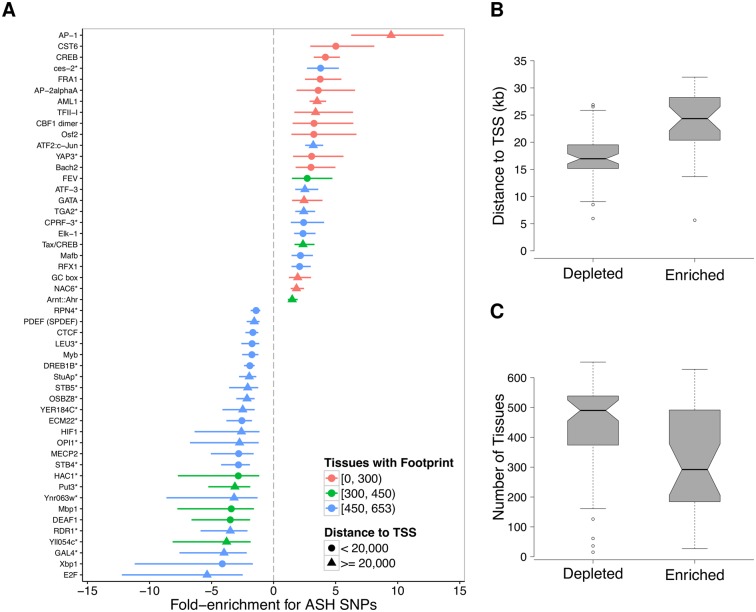
Motif-wise characteristics of functional regulatory variants.(A) Plot showing factors whose binding sites are significantly enriched (positive log2(fold change)) or depleted (negative log2(fold change)) for ASH-hSNPs, relative to the average number of ASH-hSNPs for a TF (p-value < 0.01), with indication of the number of tissues affected (color) and the median distance to the TSS (shape). Horizontal lines represent the 95% confidence interval of the ASH enrichment ratio. An asterisk denotes a possible human analog for the specified factor. Redundant motifs were excluded from the plot. (B & C) Boxplots showing the distance to the nearest TSS (B) and the number of tissues in which a motif was predicted to be active (C) for motifs either enriched or depleted for ASH-hSNPs. Notches on the boxplots are a non-parametric 95% CI interval on the median based on the inter-quartile range (IQR).